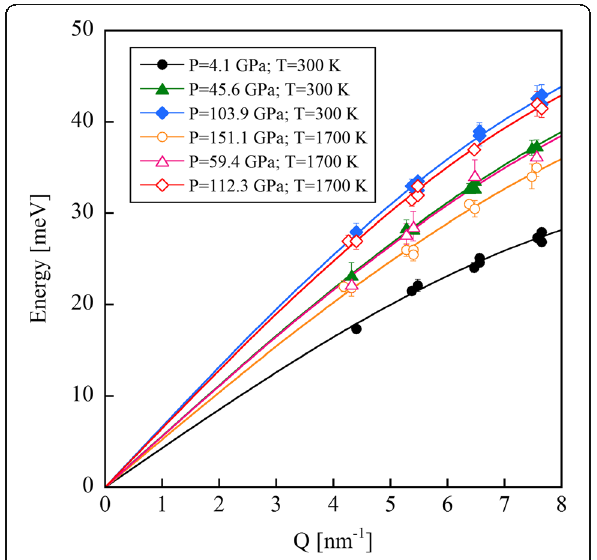
Fig. 3 LA phonon dispersion of wüstite under different experimental conditions. Solid curves are the results of sine curve fitting